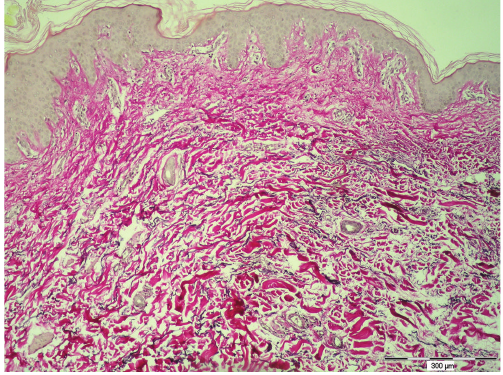
Figure 3: Pathohistological analysis of the skin showed loss of elastic tissue in the dermis and the remaining fibers were disorganized, shortened and fragmented (Orcein, bar = 300 μ m). Figure 4: Post operative anteroposterior view.